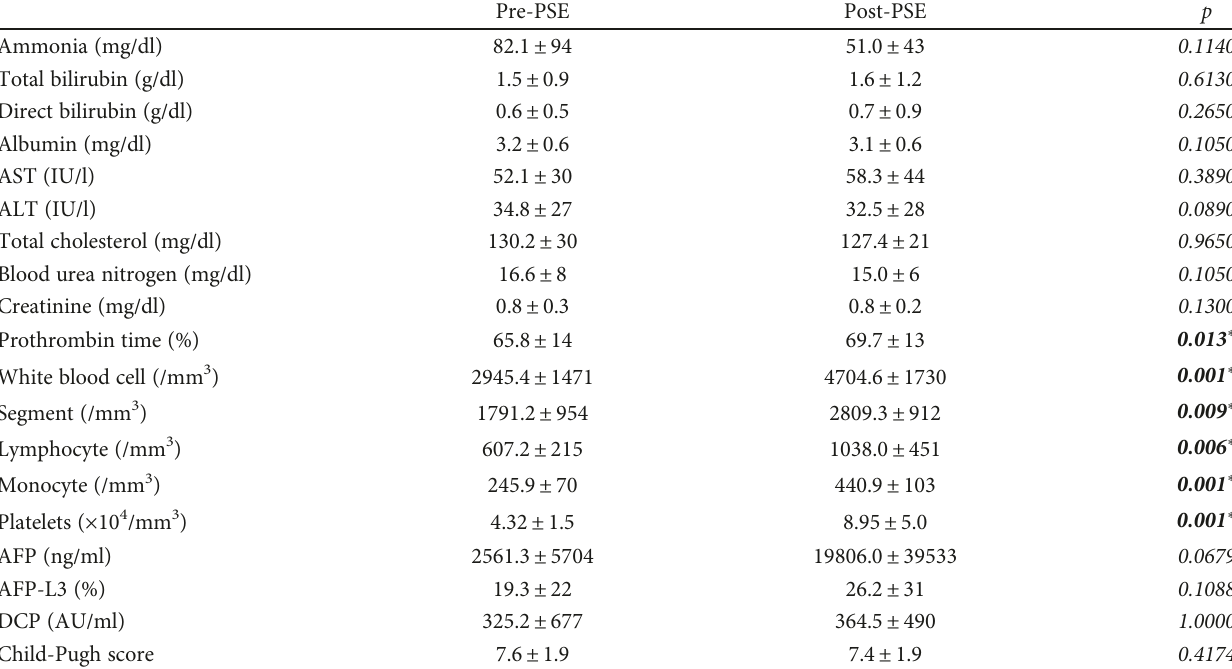
Table 2: Changes of various parameters before and after 4 weeks of PSE.